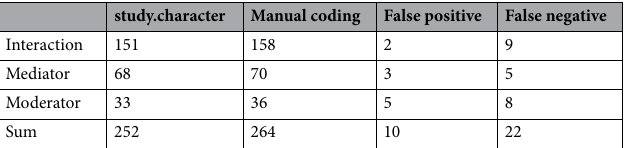
Table 8. Absolute frequencies of specific interaction effects.